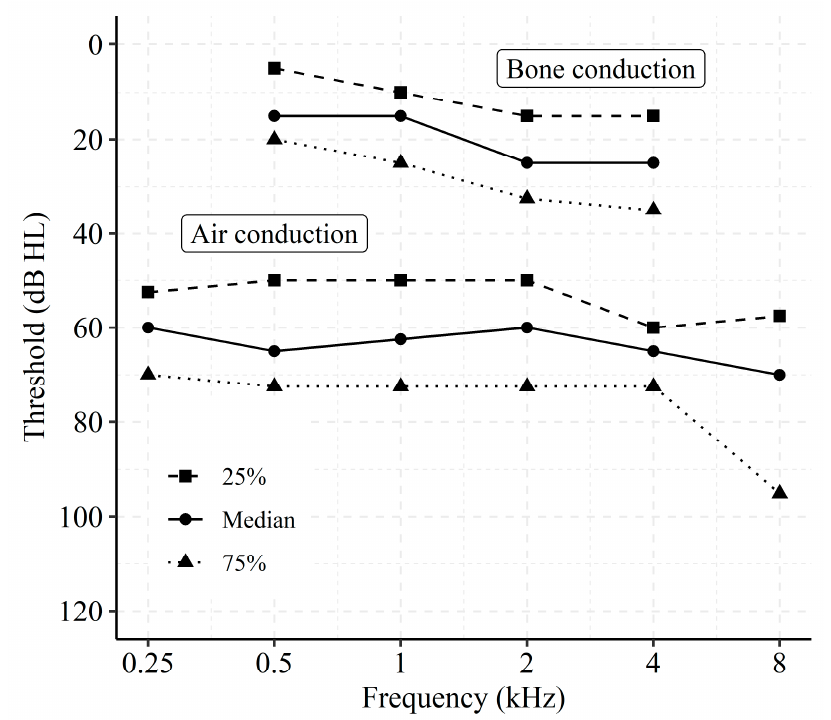
Figure 1. Distribution of air conduction and masked bone conduction thresholds at the fitted side expressed in 25%, 50%, and 75% percentiles for the 19 subjects.